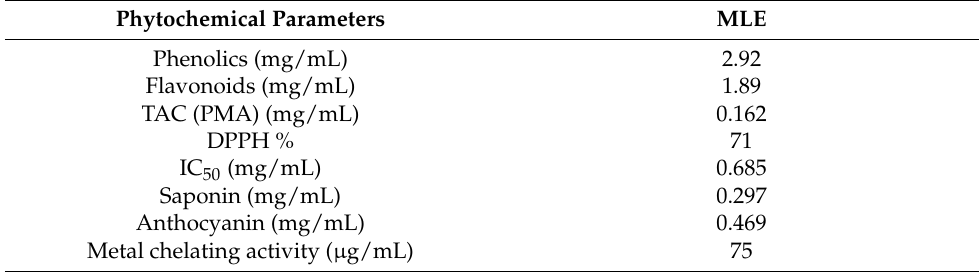
Table 1. Phytochemical analysis of Musa sp. leaves extract